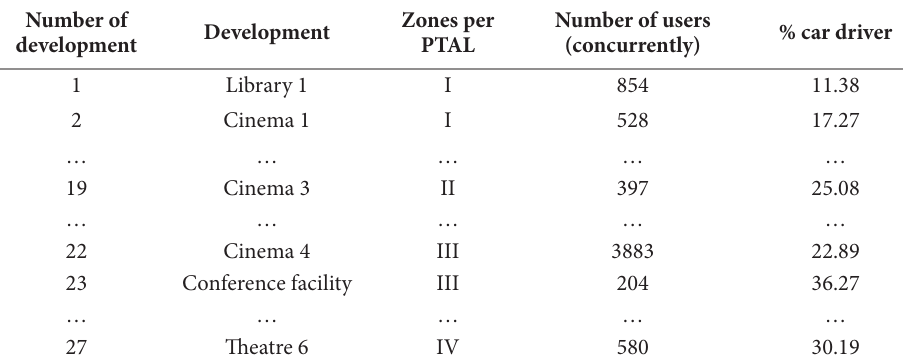
Table 4. % car driver in surveyed developments per zones per PTAL Number of development